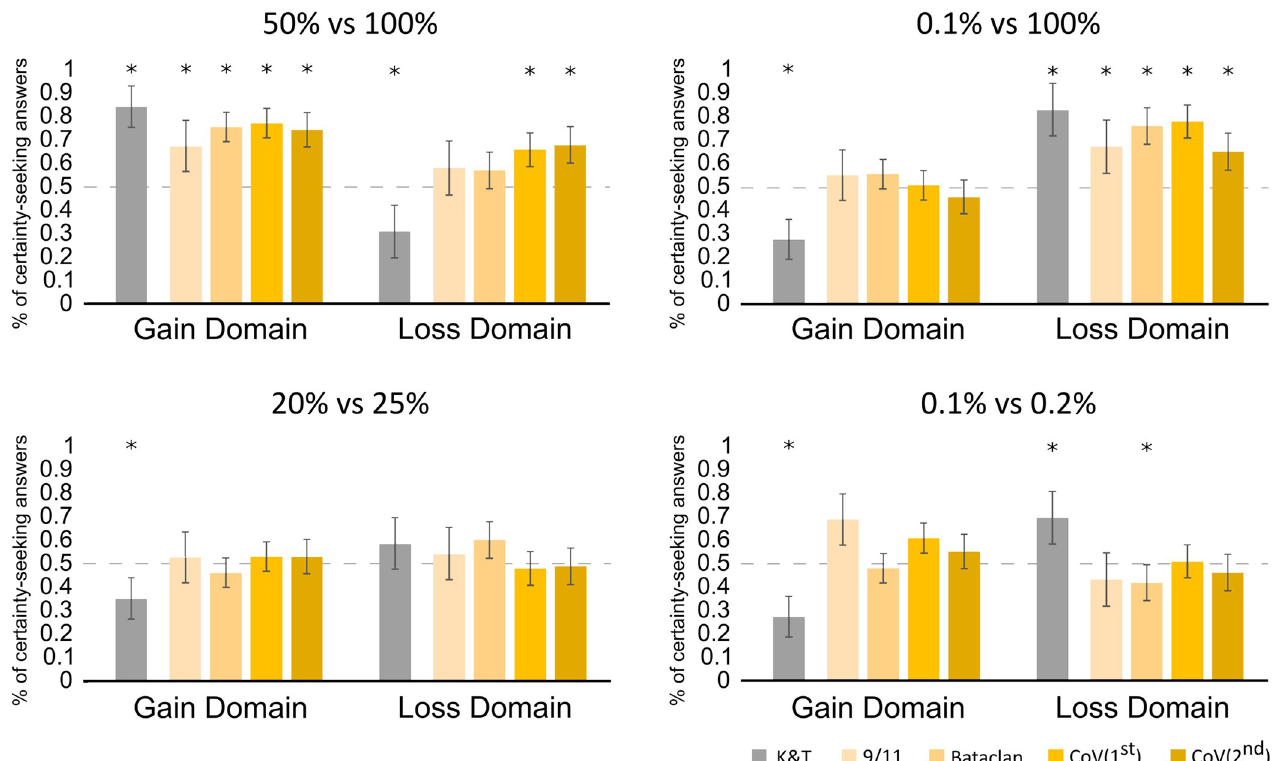
Fig 1. Percentage of individuals choosing the most likely option, by experiment: K&T (Kahneman and Tversky, 1979) [5]; 9/11 (Sacco, Blanzieri and Galetto, 2003) [9]; Bataclan (Experiment 1 of the present paper); Cov 1st (Experiment 2 of the present paper, lockdown period); Cov 2nd (Experiment 2, re-openings period). The four panels represent the four couples of prospects included in this study. Each bar represents the proportion that the prospect with a higher outcome probability was selected (e.g., 25% in 20% vs. 25% option). Error bars represent 2 standard errors; asterisks = p < 0.05. Chi squared tests for Kahneman and Tversky (1979) computed on the basis of the published